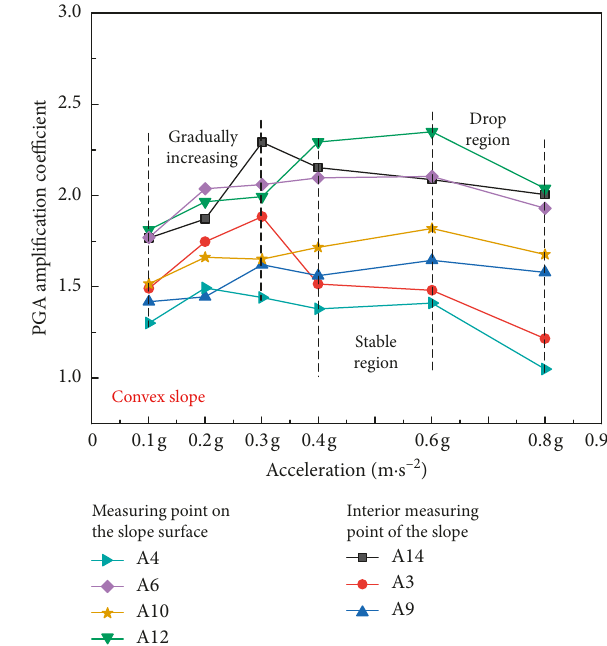
Figure 17: PGA amplification coefficients of convex slope under different El Centro waves.